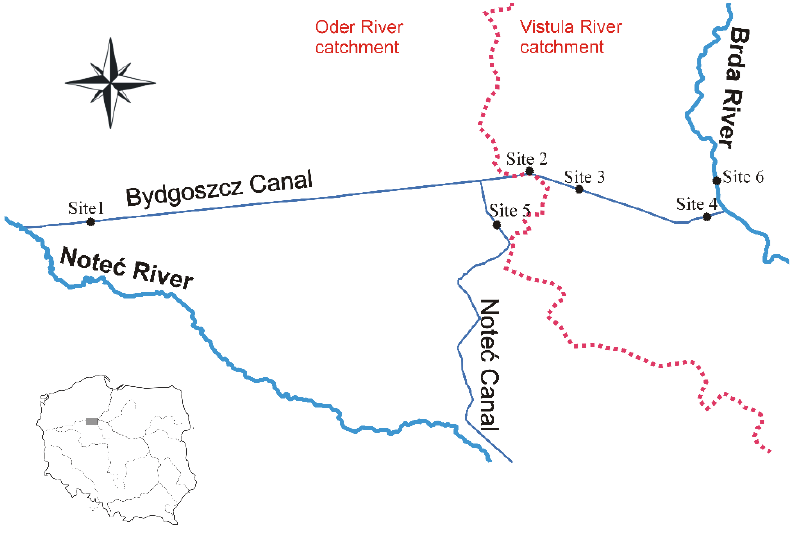
Figure 1. Map of investigated area. Bydgoszcz Canal: site 1 — Józefinki in front of the sluice; site 2 — Osowa Góra in front of the sluice; site 3 —Prądy in front of the sluice; site 4 — Okole behind the sluice; site 5 —Noteć Canal in front of the sluice ; site 6 — Brda river.